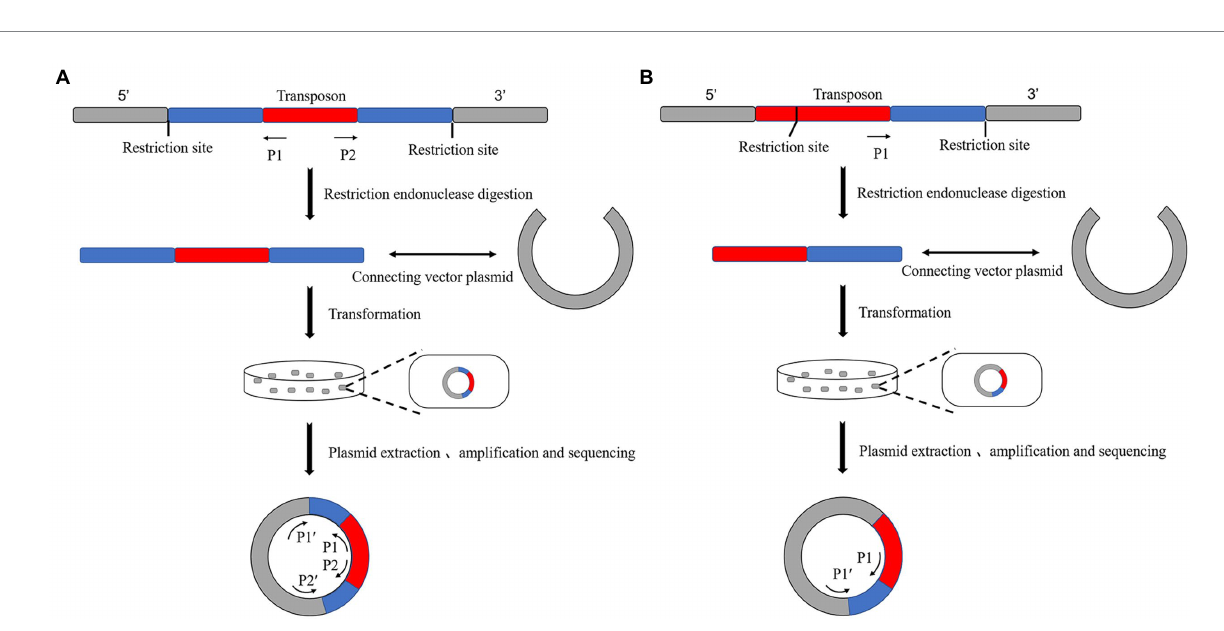
FIGURE 2 Schematic diagram of the principle of plasmid rescue. (A) There is no restriction endonuclease site on the transposon. The vector plasmid was ligated after enzymatic digestion and transformed into E. coli . The positive new bacteria were obtained by selective labeling. The plasmid is extracted, and the